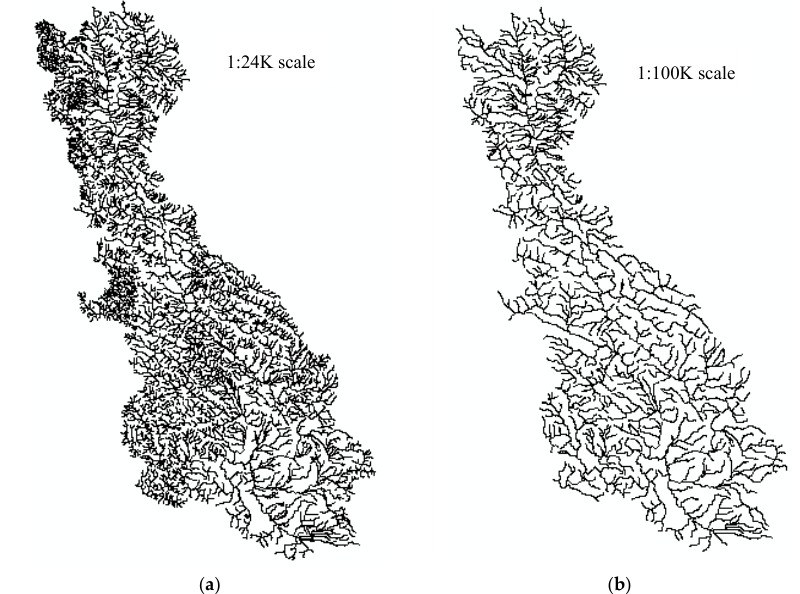
Figure 5. Experiment datasets. ( a ) is the Russian river dataset at 1:24K scale from RRIIS. ( b ) is the same area dataset at 1:100K scale from the National Hydrography Dataset (NHD).